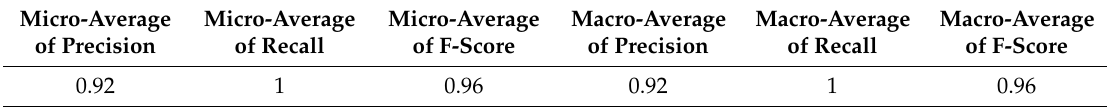
Table 12. Performance evaluation of the system based on Micro-average method and Macro- average